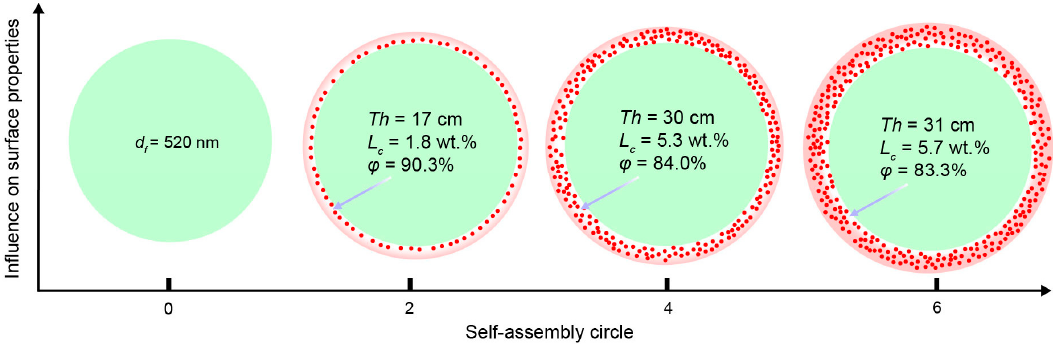
Figure 6. Assembly process with an increase in self-assembly cycles.